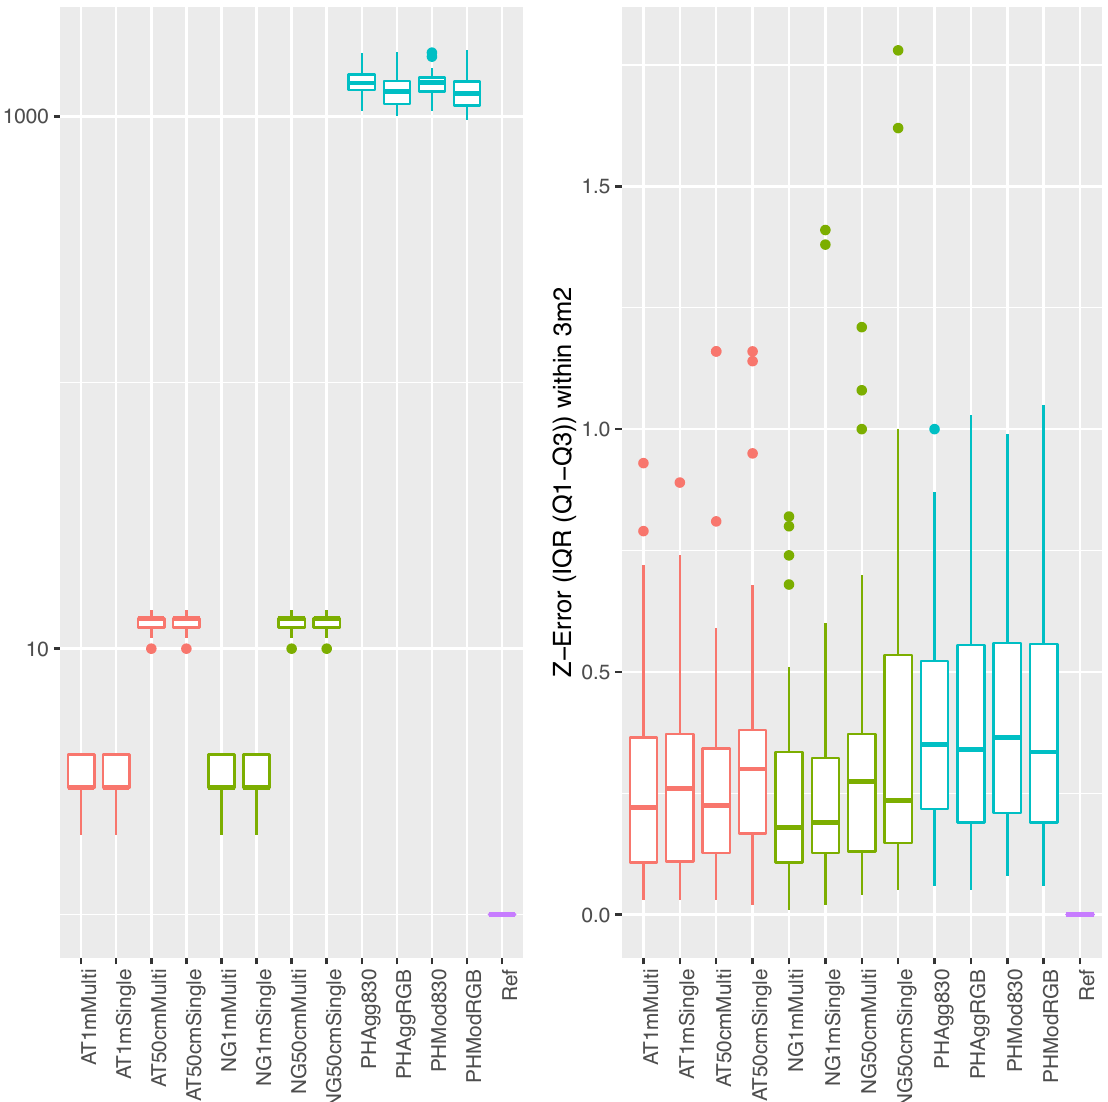
extracted points for PHS (> 1000) and several reference points with snow crests leads to an even slightly increased height IQR (blue boxplots in Figure 4 right (PHAgg830 ... PHModRGB)). Overall the height error of the reference points seem to be evenly distributed and each reference point is therefore equally